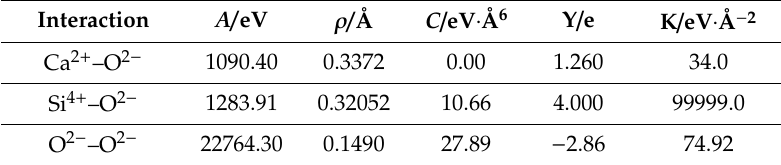
Table 1. Buckingham potential parameters [33,34] used in the classical simulations of CaSiO 3 .